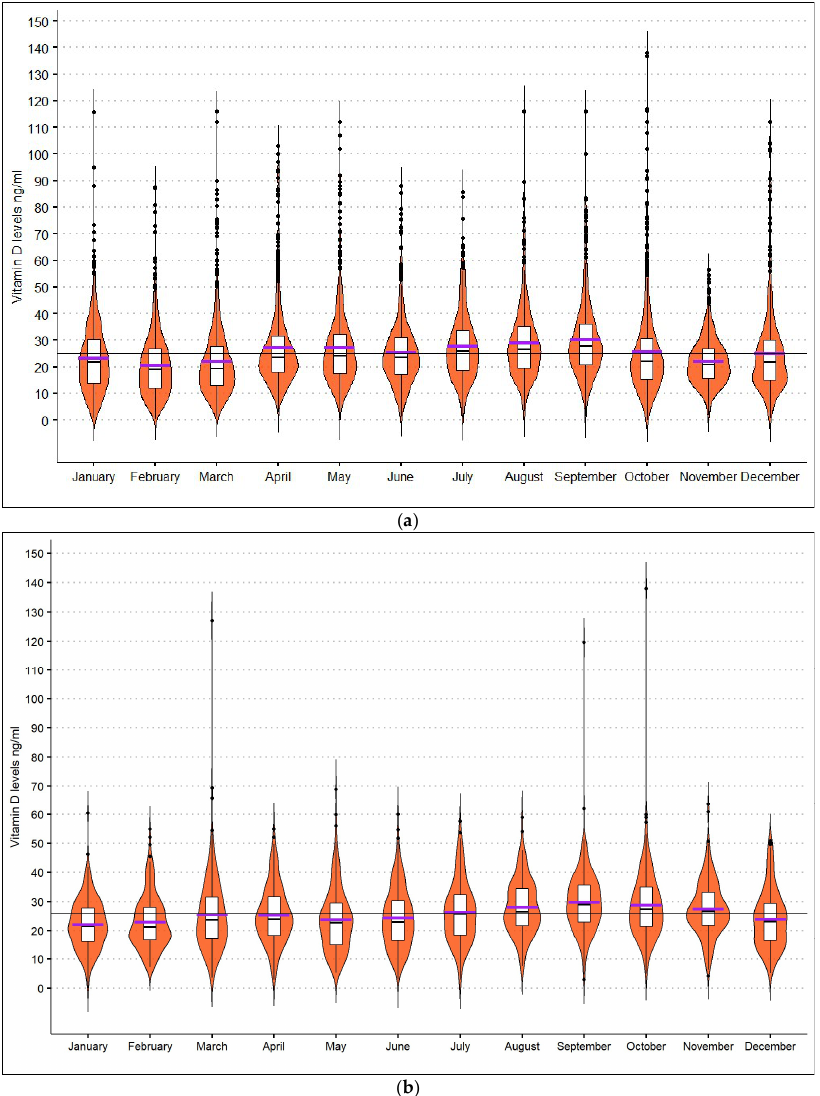
Figure 2. (a) Boxplots demonstrating the fluctuance of 25 ( OH ) D levels by month for the Greek database. The purple line represents the mean, and the short black horizontal line the median. The continuous horizontal line represents the mean of the whole Greek population sample throughout the year. (b) Boxplots representing the fluctuance of 25 ( OH ) D levels by month for the Cypriot sample. The purple horizontal lines represent the mean, and the black short horizontal lines the median levels for each month. The continuous horizontal line represents the mean of the whole Cypriot population sample throughout the year.